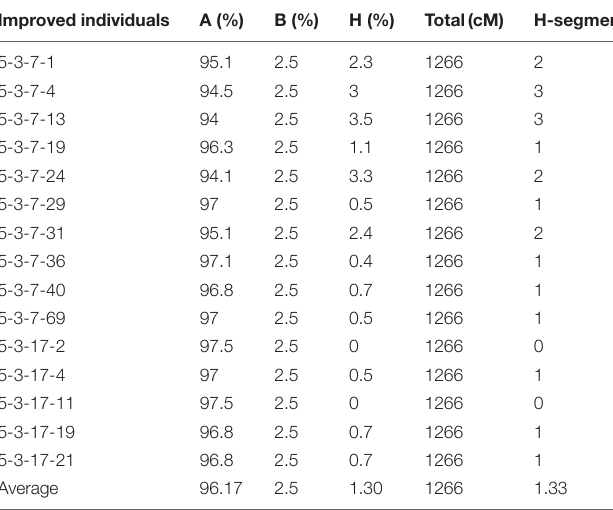
TABLE 7 | Introgressed and background recovery analysis in selected improved lines. Improved individuals